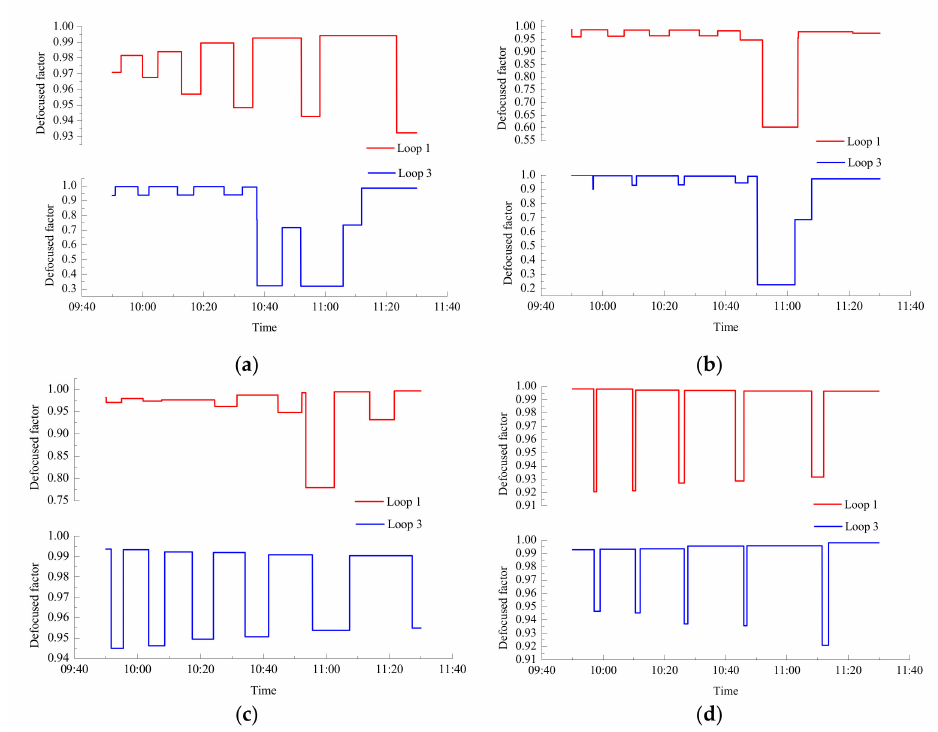
Figure 12. Defocused factor of the solar collector assemblies (SCAs) in Loop 1 and Loop 3: ( a – d ) SCA 1 to